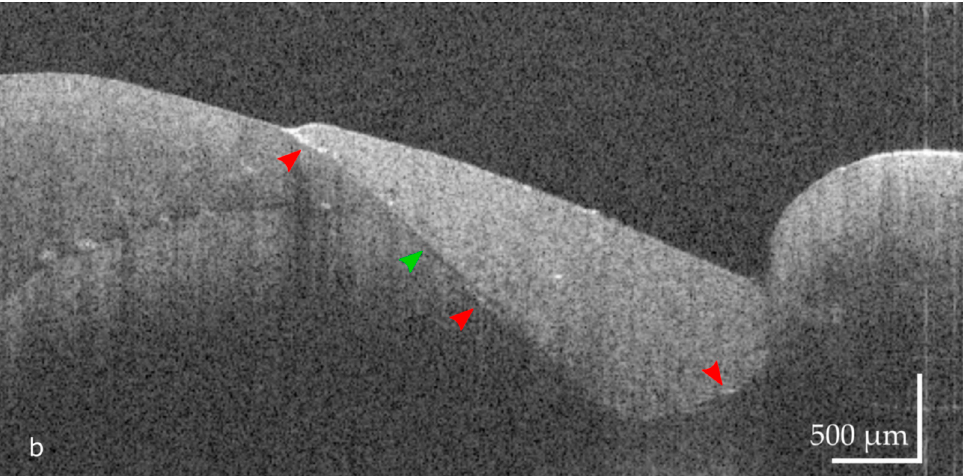
Figure 1. Tooth 45. The Class V cavity was restored with SbM/Amaris. The OCT cross-sectional images of two slices of the restoration show composite (C), enamel (E), dentin (D), the enamel-dentin junction (EDJ), and the gingiva (G). Interfacial adhesive defects (bright lines, red arrow heads) appear on both dentin ( a , b ) and enamel ( b ), and their lengths can be determined. Partially, the adhesive layer also appeared (green arrowhead, dark interfacial zone). Scales refer to refractive index n = 1.0.